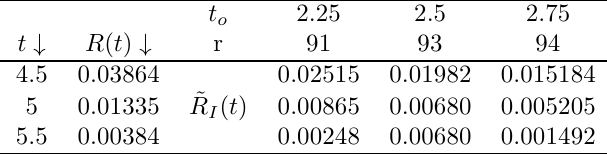
UMVUE’S of R(t) obtained under Type-I